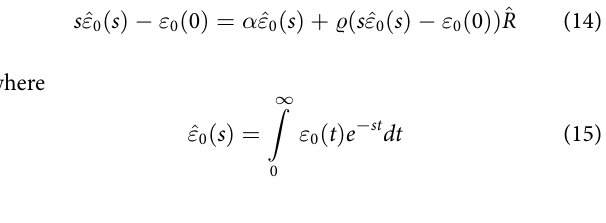
causality. The area under the curve shall be normalized to unity.